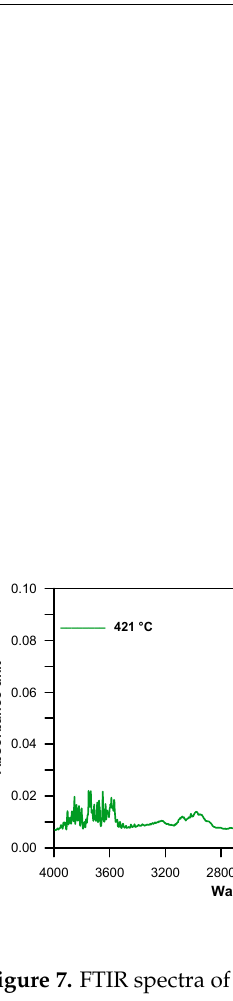
Table 5. TG and DTG data of the copolymeric microspheres obtained in synthetic air